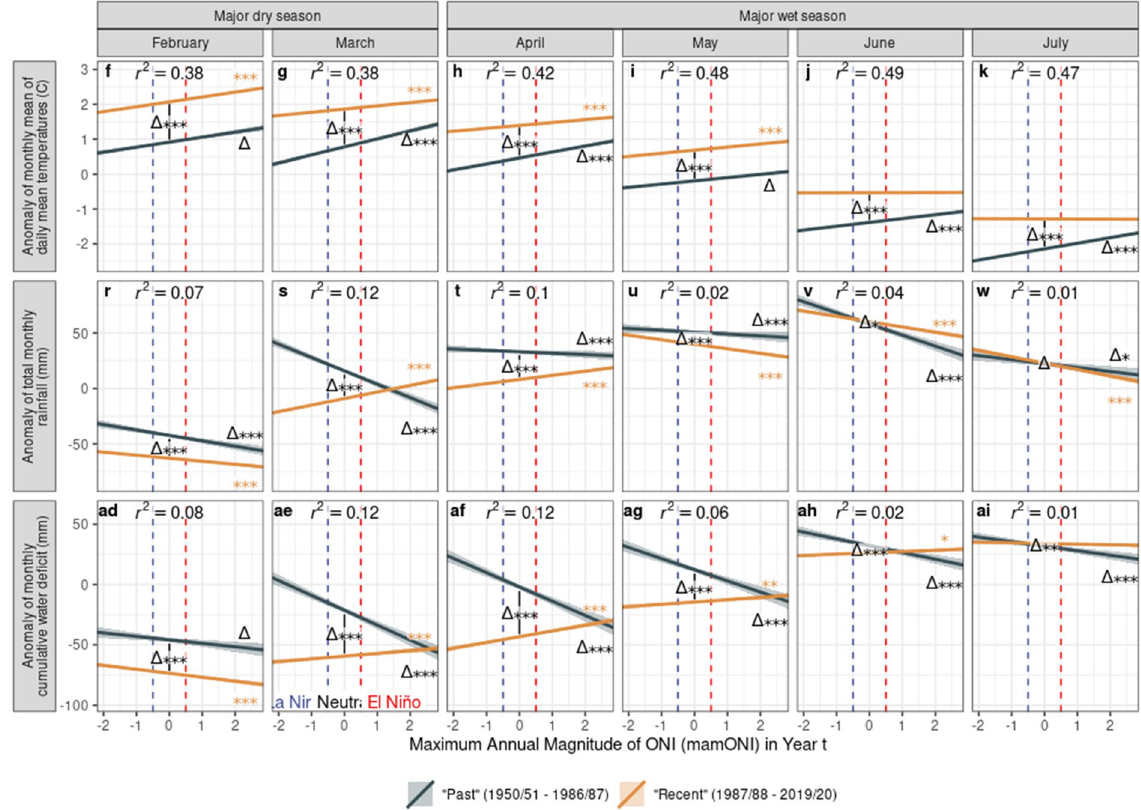
Figure 5. The response of climate to mamONI in selected months during the purchase year, grouped into two sets of years corresponding to the best fitting break-point in the production data. Supplementary Fig. 1 shows a complete version with all months; panel letters are consistent across this plot and Supplementary Fig. 1, hence the missing letters in this plot. Lines show the best linear fits and standard errors derived from individual regressions of monthly climate against mamONI, with an interaction term fitting the year category. All colours and notations as in Fig. allocating resources away from reproduction in the short term and creating oscillating resource allocation over the following years. However, understanding the delayed responses of cocoa is challenging, especially as these represent a novel finding. There is little research that explores multi-annual physiological or ecological responses of cocoa to drought, and the explanation is likely to be a combination of both residual/delayed climatic responses to ENSO phase, and of life history strategies. The observed increase in production during the two years following El Niño